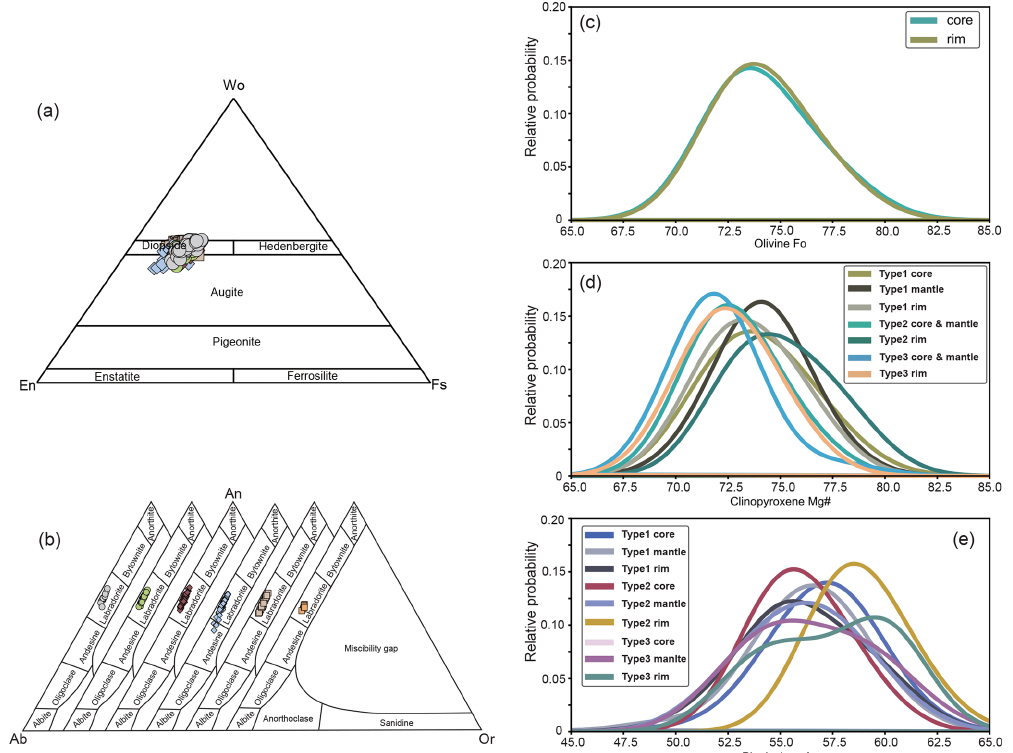
Figure 4. Major element composition of main mineral phases observed in the WVF. (a) Compositional classification diagram of pyroxene. (b) An–Ab–Or ternary classification diagrams of feldspar. Kernel density estimation (KDEs) for Fo content of olivine (c) ; Mg# values of clinopyroxene (d) ; An content of plagioclase (e)